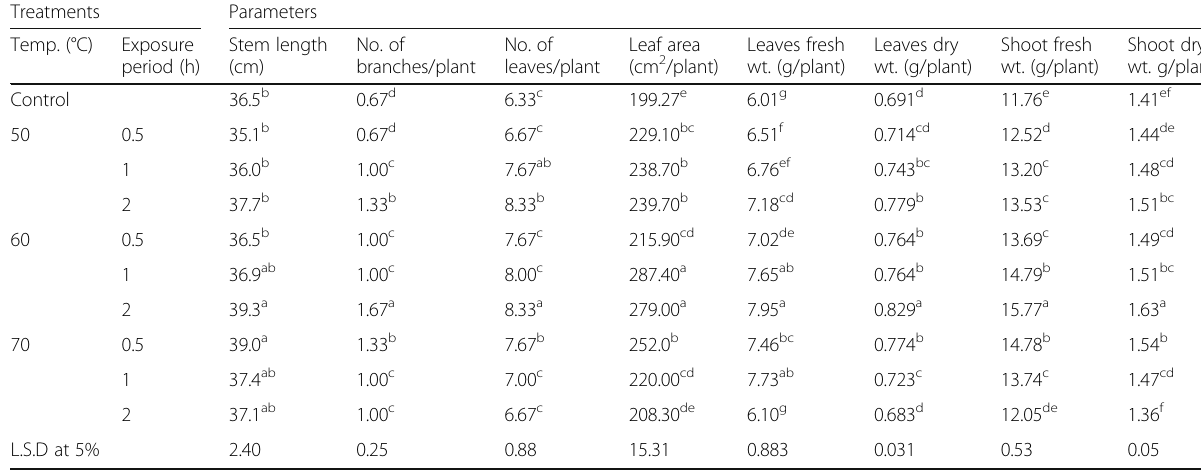
Table 4 Effect of seed hardening on vegetative growth Treatments Parameters Temp.